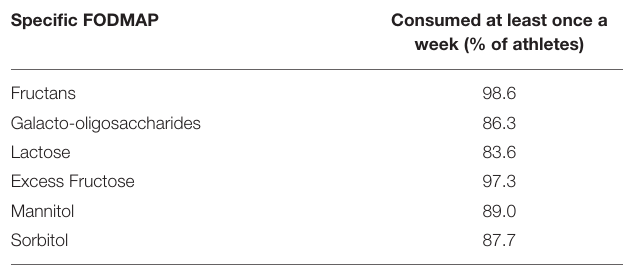
TABLE 5 | Percentage of endurance athletes ( n = 73) consuming high TABLE 4 | Habitual fermentable oligosaccharides, disaccharides, fermentable oligosaccharides, disaccharides, monosaccharides, and polyols monosaccharides, and polyols (FODMAP) intakes of endurance athletes ( n = 73). (FODMAP) foods at least once a Daily Intake (g) Specific FODMAP